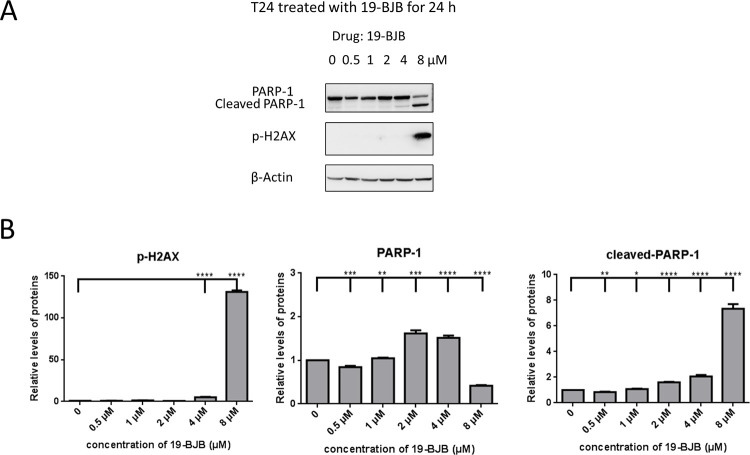
Western blots analysis of 19-BJB in 24 h.(A) T24 cells were treated with 19-BJB in varying concentration for 24 h and total cell lysates were analyzed for the expression of DNA damage repair related protein PARP-1, cleaved PARP-1, p-H2A.X. Equal protein loading was confirmed by reprobing membrane with β-actin after stripping. The relative levels of all proteins are performed (B) as means ± SD from triplicate samples for each treatment. *p < 0.05, **p < 0.01, ***p < 0.001, ****p < 0.0001.